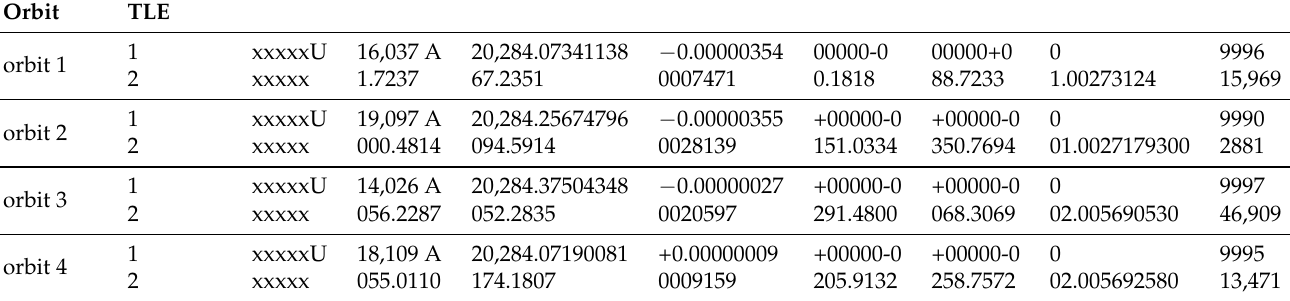
Table 1. TLE of simulated